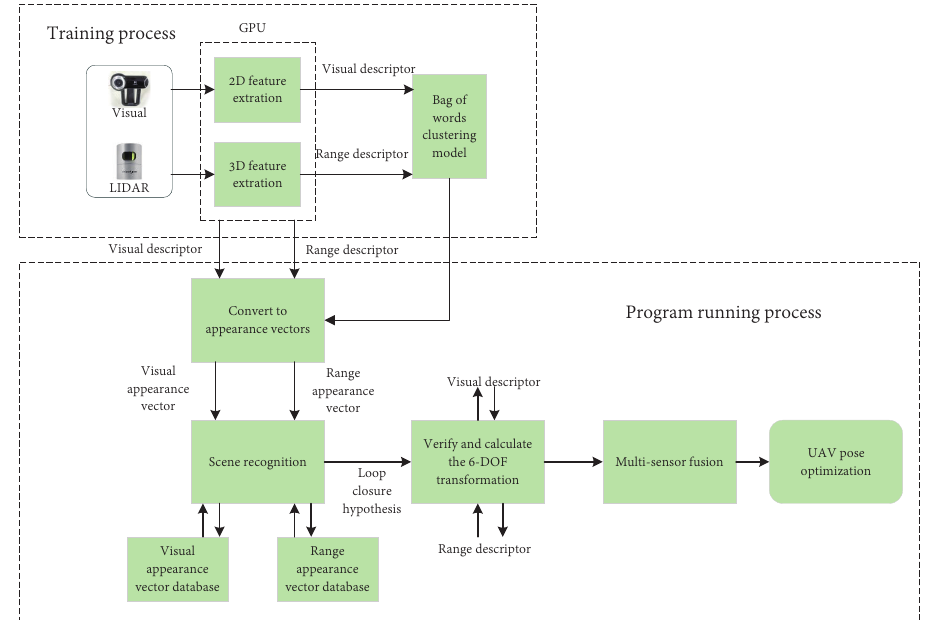
Figure 16. Frame diagram of multi-sensor fusion based on the FAB-MAP algorithm. The camera and LIDAR information is extracted by the GPU, and SIFT and VD-LSD are used to train the bag-of-words model of the LIDAR and visual sensors. Then, the information is converted into the respective appearance vectors for the loop closure detection process. After the calculation and verification of the 6-DOF, multi-sensor data fusion is carried out, and the pose optimization of the UAV is finally